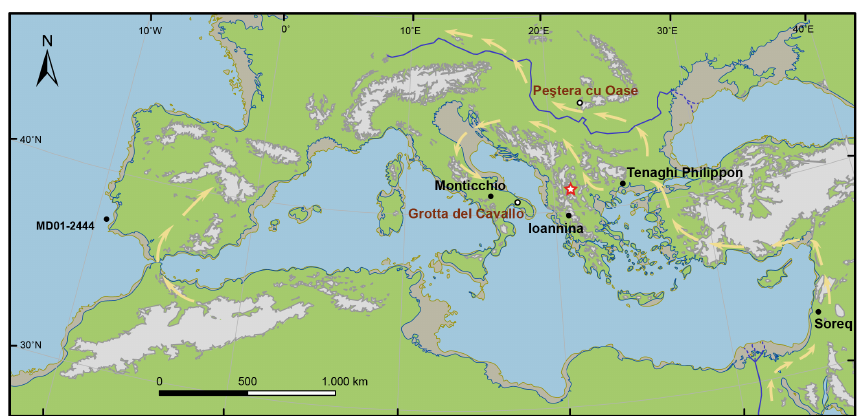
Fig. 1. Locations of the records described, including Lake Prespa (star); archaeological sites are marked with an open circle. Note the paleo-coastline during MIS 3 at 100m below present sea level (in beige) and possible dispersal routes of modern humans